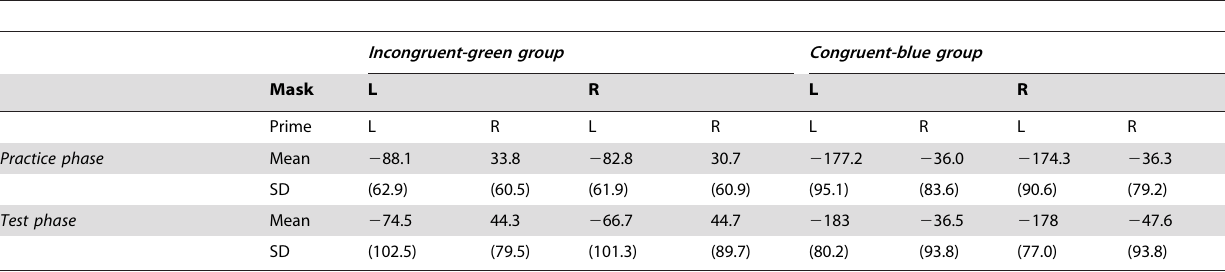
Table 3. Mean velocity of the 100-ms window in each condition of incongruent-green and congruent-blue groups in the practice and test phases.